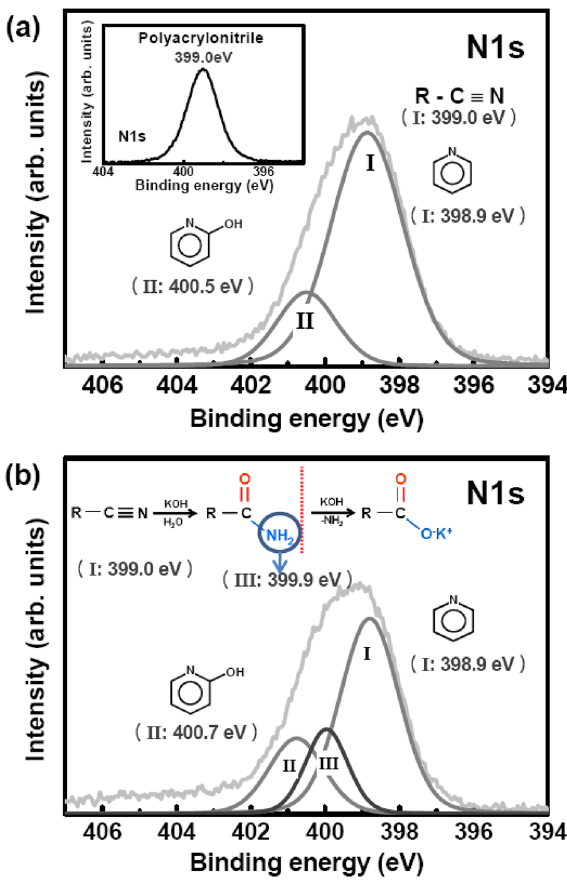
Figure 5. N1s peaks for the ( a ) pristine and ( b ) hydrolysed PAN